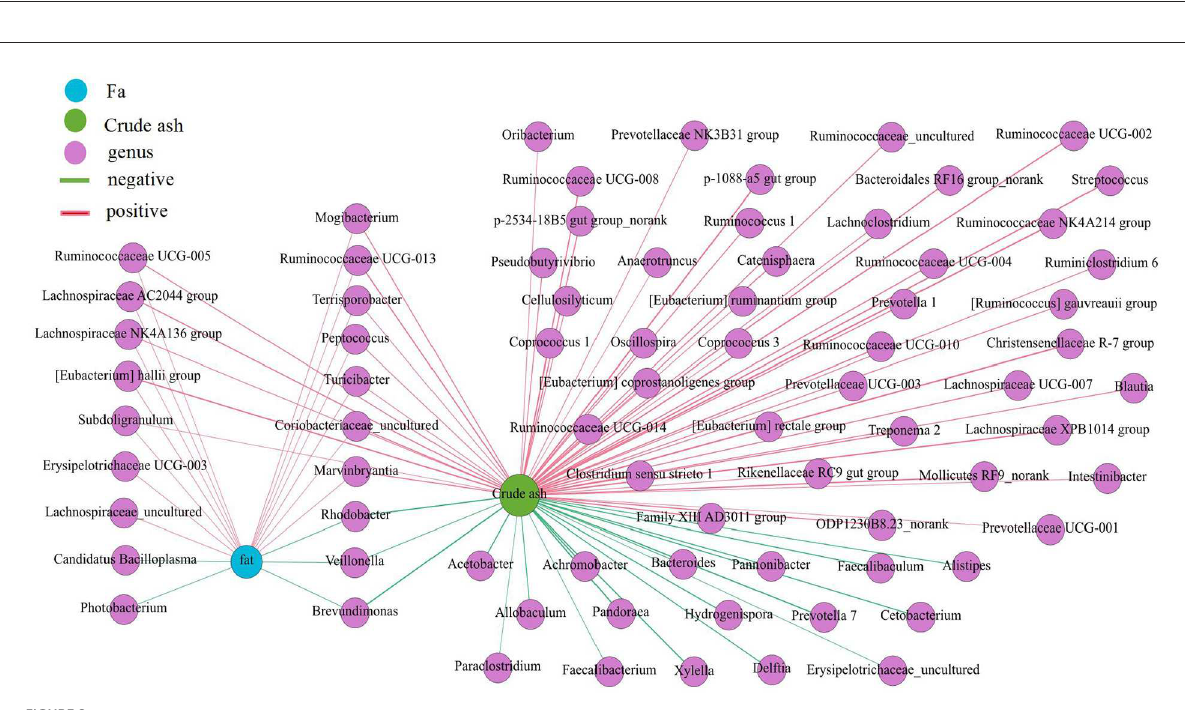
FIGURE8 Correlation analysis between the microbial community and the concentration of fat and crude ash in intestine of pigs. The association between the top 100 genera and the fat and crude ash were analyzed using Spearman’s correlation method. The node size is proportional to the number of